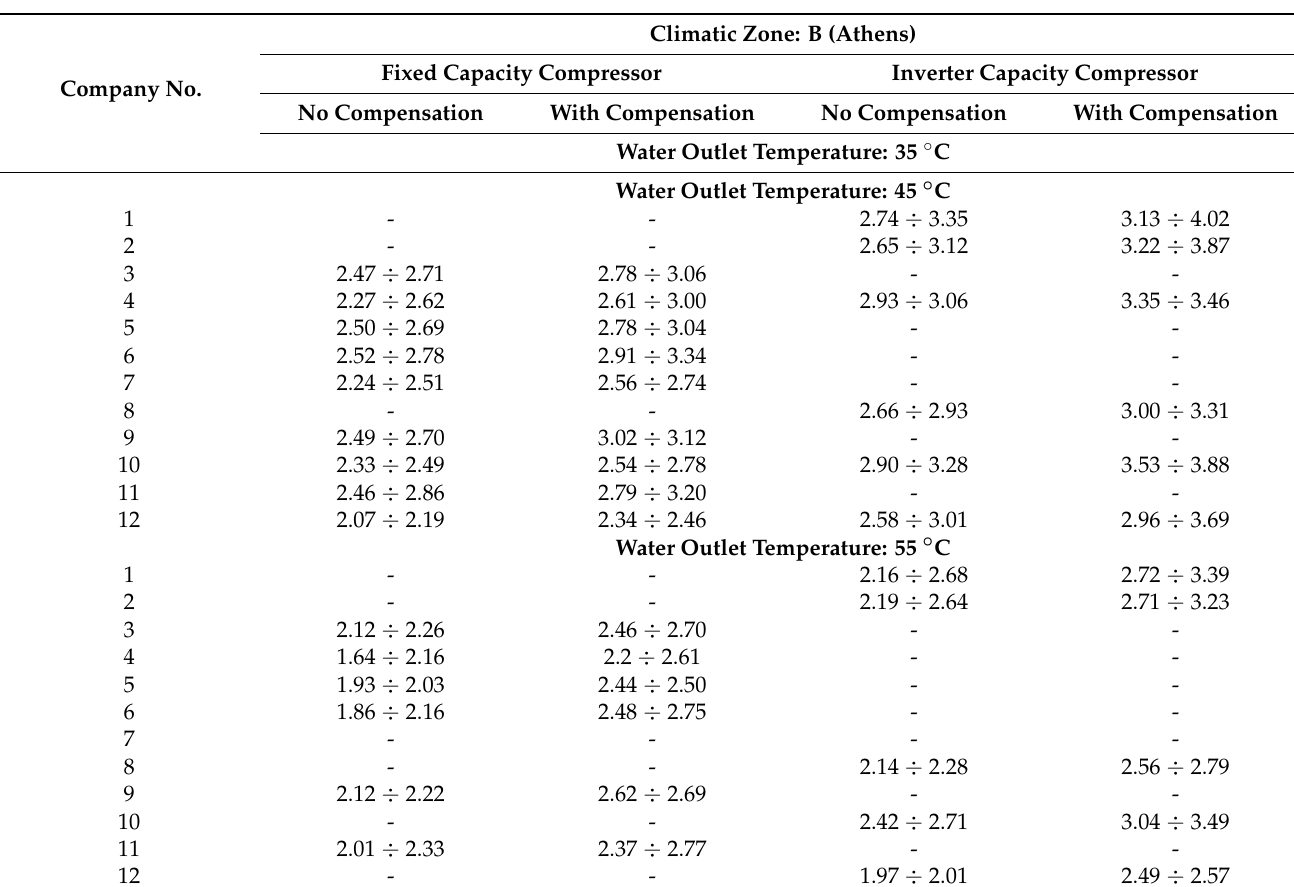
Table 6. AWHPs’ SCOP per company: Thessaloniki, water outlet temperature 35, 45, and 55 ◦ C.